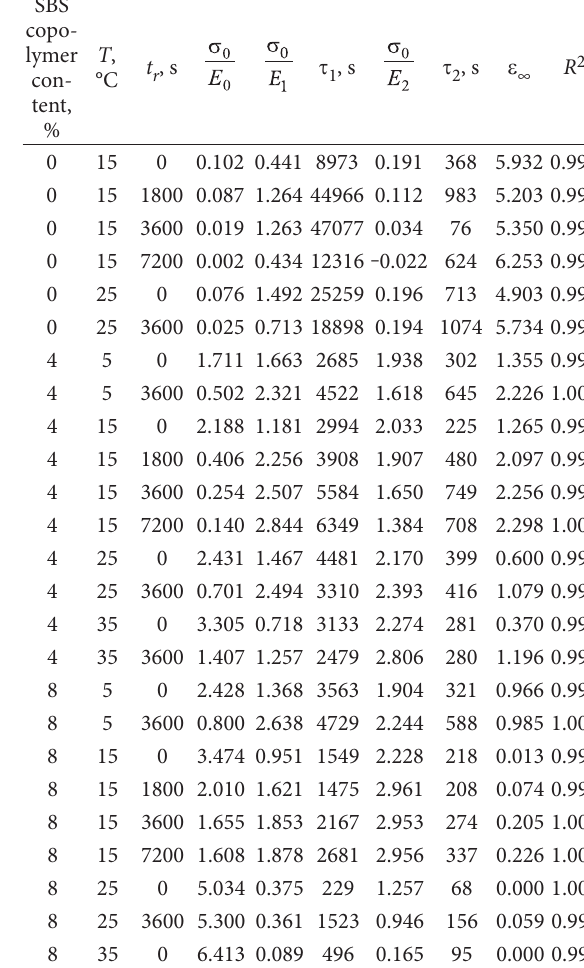
Table 4. Results of modelling of the inverse creep of the tested asphalt binders – parameters of the Dual Kelvin+Maxwell model SBS